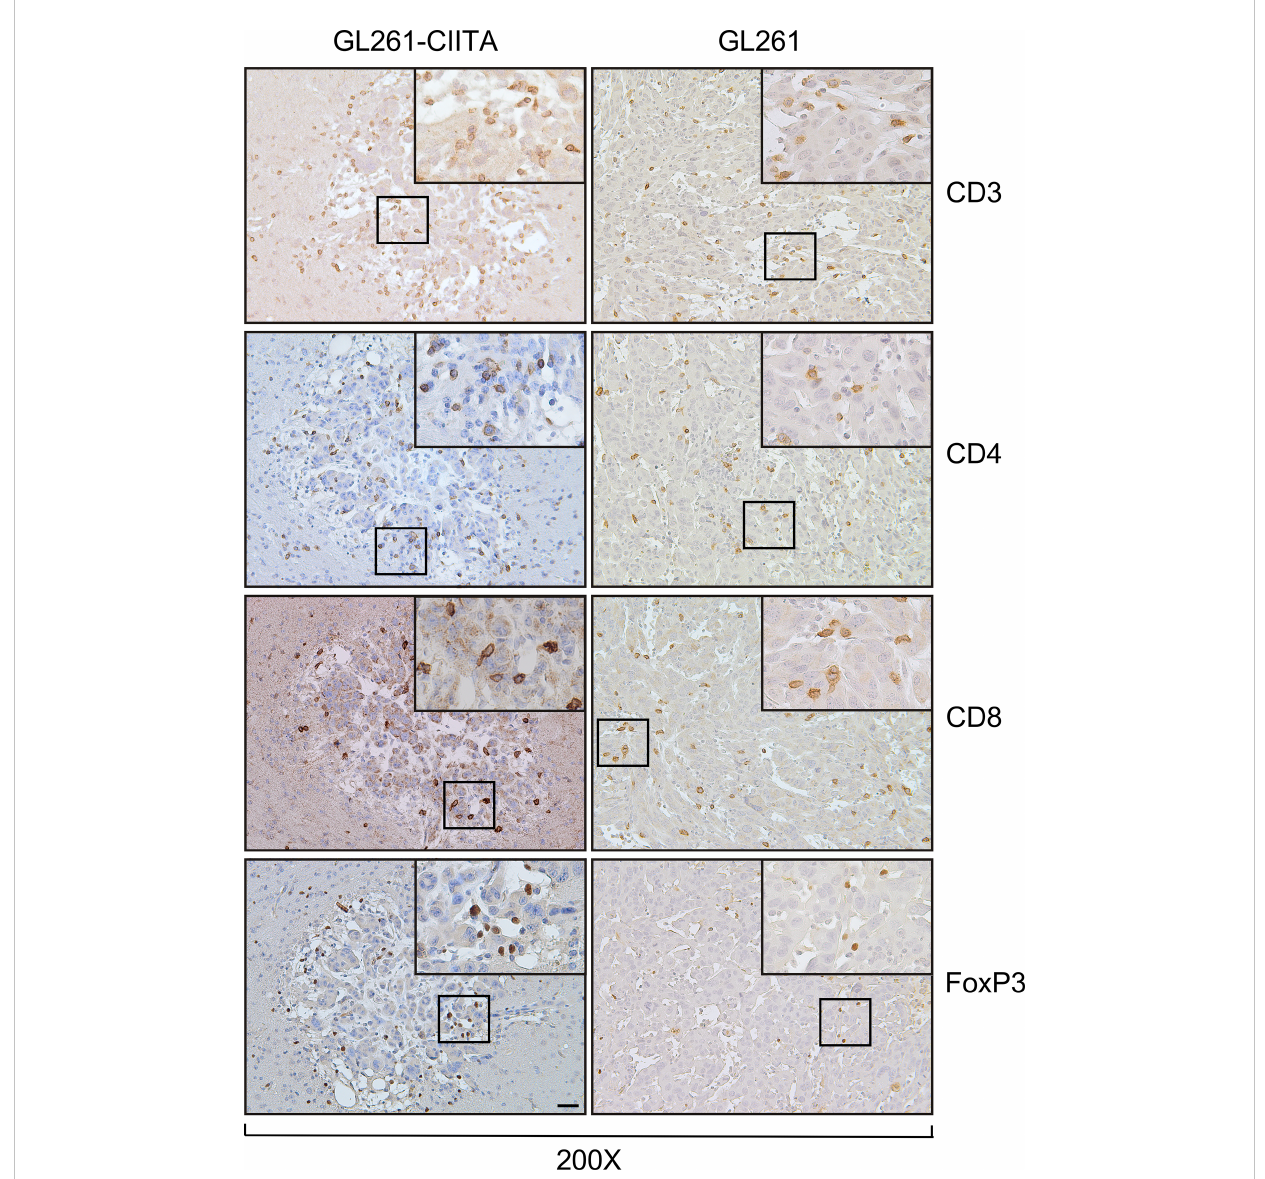
FIGURE 3 GL261-CIITA tumors are strongly in fi ltrated by both CD4 and CD8 T cells: immunohistology. C57BL/6 mice received intracranial injection of 3 × 10 4 GL261 or GL261-CIITA glioma cells. On day 21 after injection, mice were sacri fi ced, brains were removed, and serial sections of the brain were carried out for staining for CD3, CD4, CD8, and FoxP3 in both GL261 (right panels) and GL261-CIITA (left panels). Small square boxes are the areas represented in the corresponding large square boxes of each IHC image. Images were taken at ×200 magni fi cation; scale bar corresponds to 50 m M. Large square boxes were taken at ×400 magni fi cation. Note that selected areas in IHC images of GL261 parental tumors were taken in the rare zones in which positive cells for the selective marker were present. IHC,